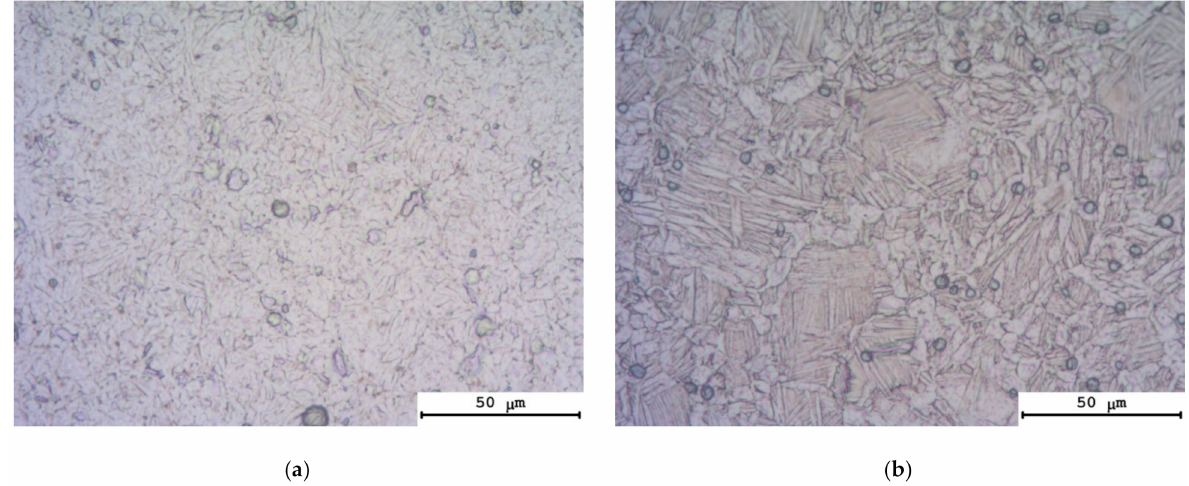
Figure 13. Optical microscopy images of the specimens’ surfaces of the Ti5Al2V ( a ) and Ti6Al4V ( b ) alloys after electro- chemical testing.